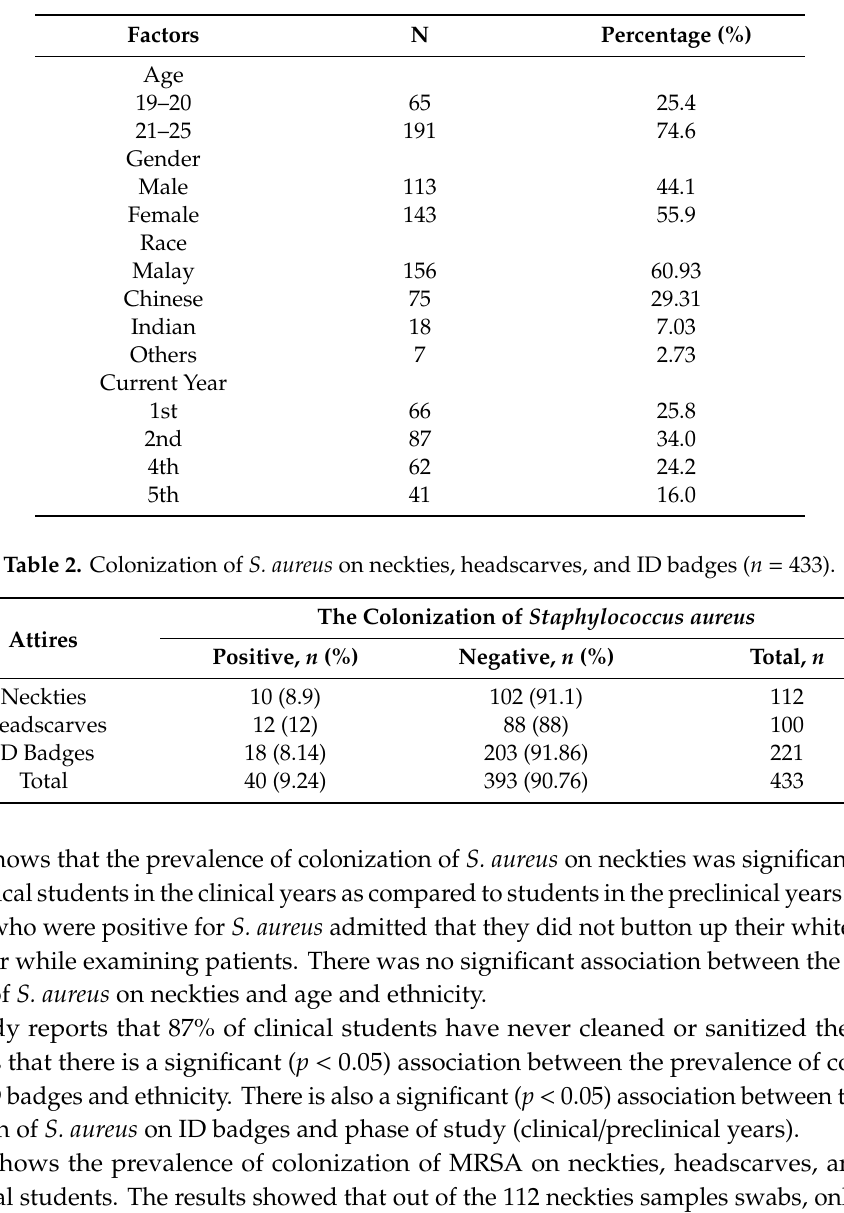
Table 1. Socio-demographic characteristics of respondents ( n = 256).